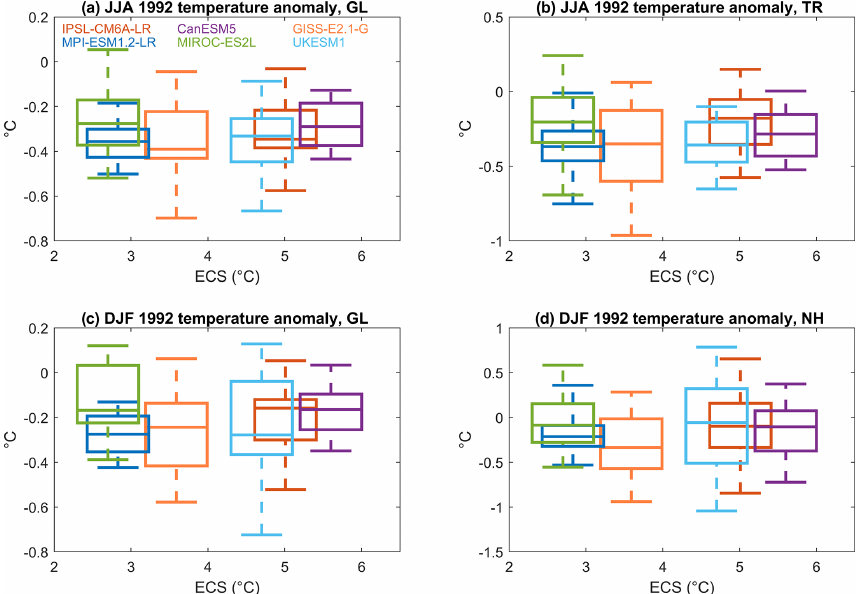
Figure 13. Box–whisker plots of simulated post-eruption near-surface air temperature anomalies in the volc-pinatubo-full simulations as a function of equilibrium climate sensitivity (ECS). (a, b) Global-mean (GL) and tropical-mean (TR) anomalies for the second post-eruption boreal summer; (c, d) GL and Northern Hemisphere-mean (NH) anomalies for the second post-eruption boreal